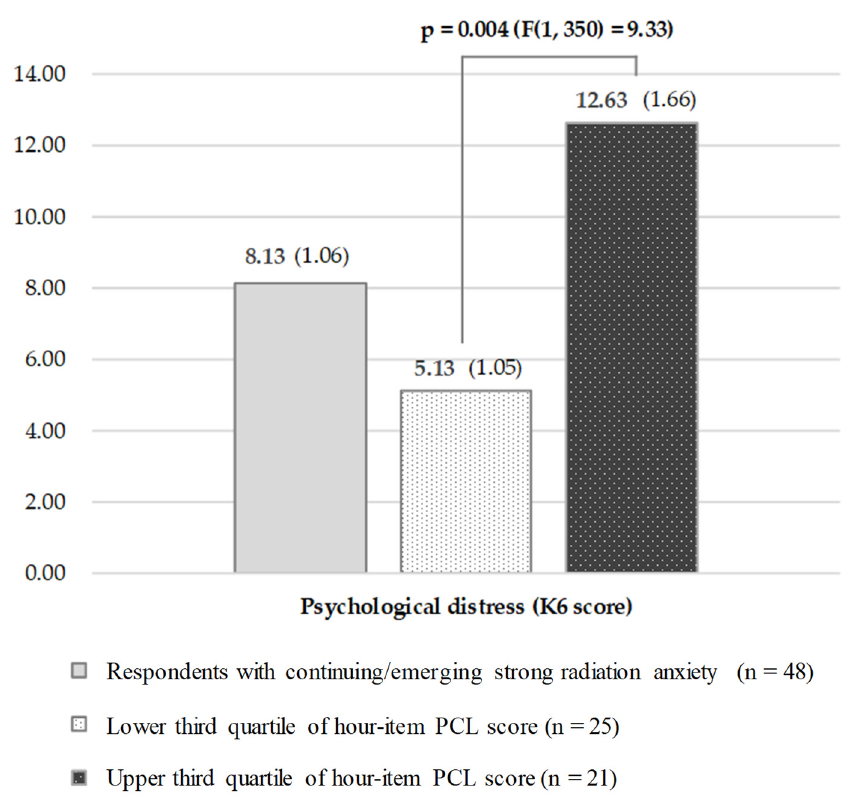
Figure 4. Psychological distress among those who have continuing/emerging strong radiation anx- iety, stratified by post-traumatic stress levels: K6 score (stratified by post-traumatic stress), adjusted by age, gender, educational background, and living area in Fukushima. Parentheses ( ): SD, standard deviation.